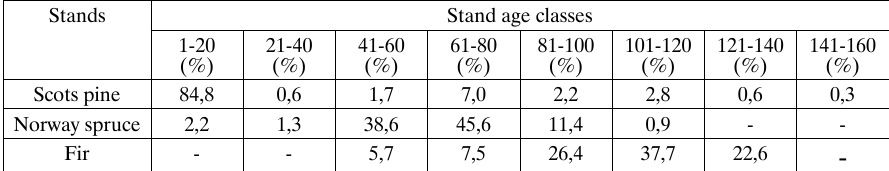
Percentage of samples of Armillaria from coniferous stands: Scots pine stands, Norway spruce stands and fir stands considering different stand age